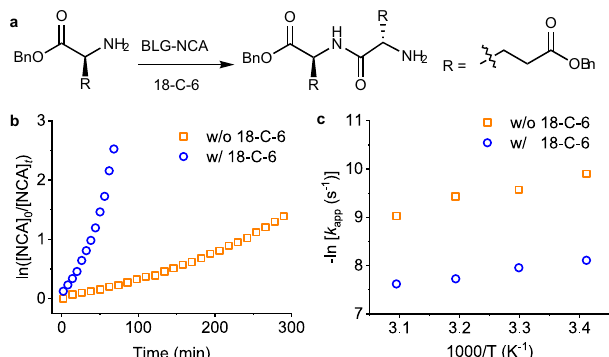
Fig. 5 Ring-opening reaction of NCA catalyzed by CE. a Scheme illustrating CE-catalyzed ring-opening reaction of BLG-NCA by DBLG. b Semilogarithmic kinetic plot of ring-opening reaction of BLG-NCA in DCM by DBLG in the presence and absence of 18-C-6 at room temperature by FTIR. c Arrhenius plot of ring-opening reaction of BLG-NCA by DBLG in CDCl 3 in the absence and presence of 18-C-6. [DBLG] 0 = 30 mM, [NCA] 0 = [CE] 0 = 3 mM.